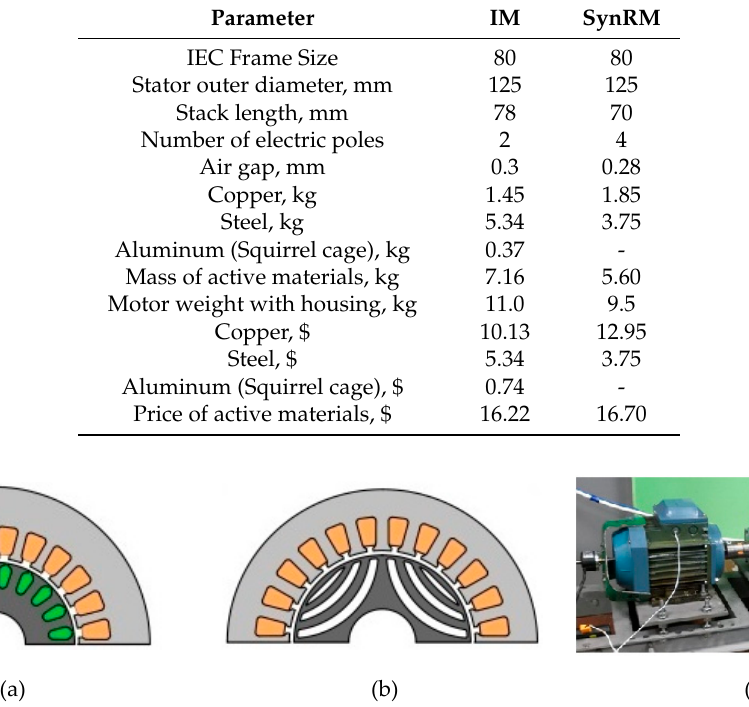
Table 3. Dimensions, mass and cost of the active materials of 1.1 kW, 3000 rpm motors.